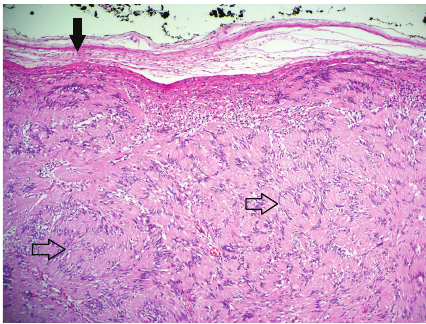
Figure 1: Encapsulated mesenchymal tumor (H&E, × 10): capsule (arrow), Verocay bodies (open arrow).